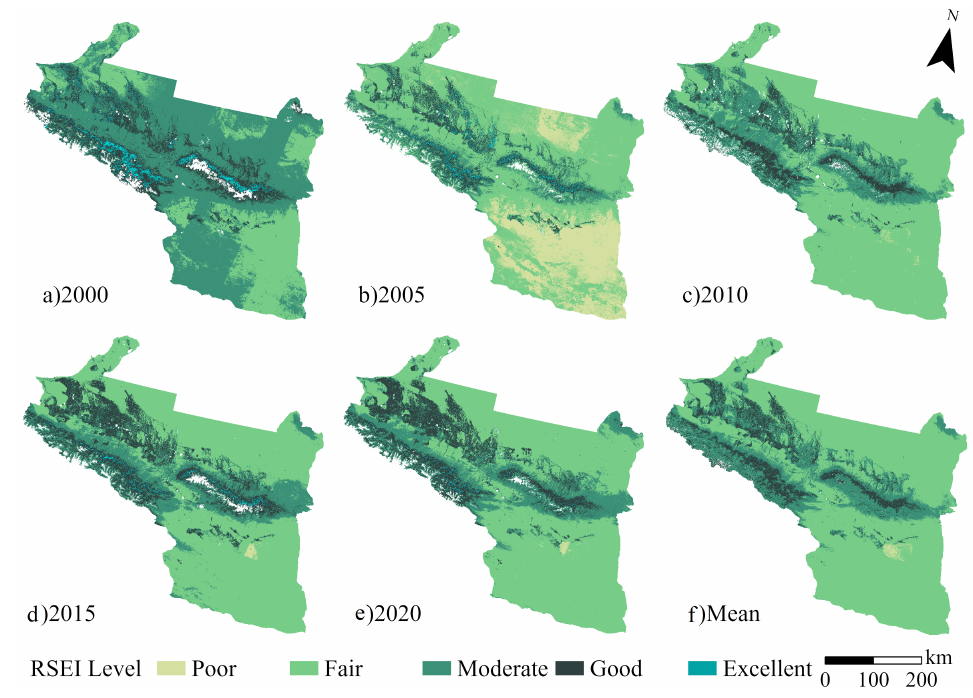
Figure 5. Spatial distribution of RSEIs from 2000–2020.